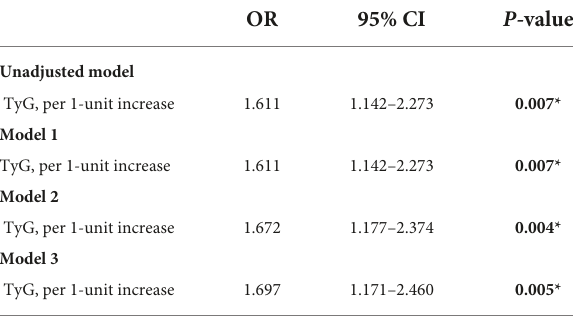
TABLE 3 Association of TyG index with the risk of post-PCI QFR ≤ 0.92 in logistic regression